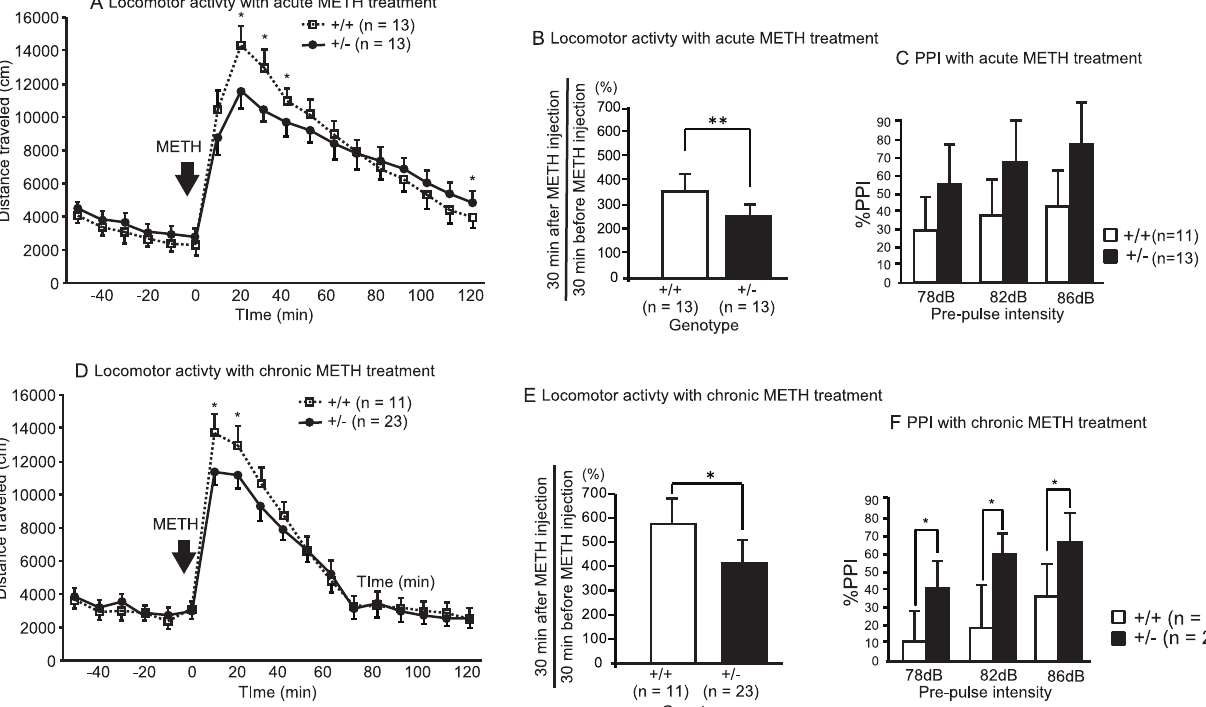
Figure 2. Effect of METH administration on locomotor activity and prepulse inhibition. Relative locomotor activity and prepulse inhibition after acute (A, B, C) and chronic (D, E, F) administration of METH in Pdlim5 + / + and Pdlim5 + / 2 mice. Values are shown as mean 6 SD. * p , 0.05 and ** p , 0.01 by ANOVA.